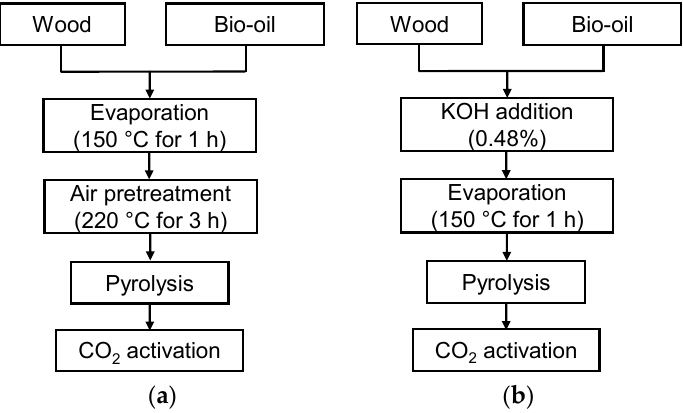
Figure 4. Activated carbon preparation methods with air pretreatment ( a ) and KOH addition ( b ) prior to pyrolysis of wood with bio ‐ oil.